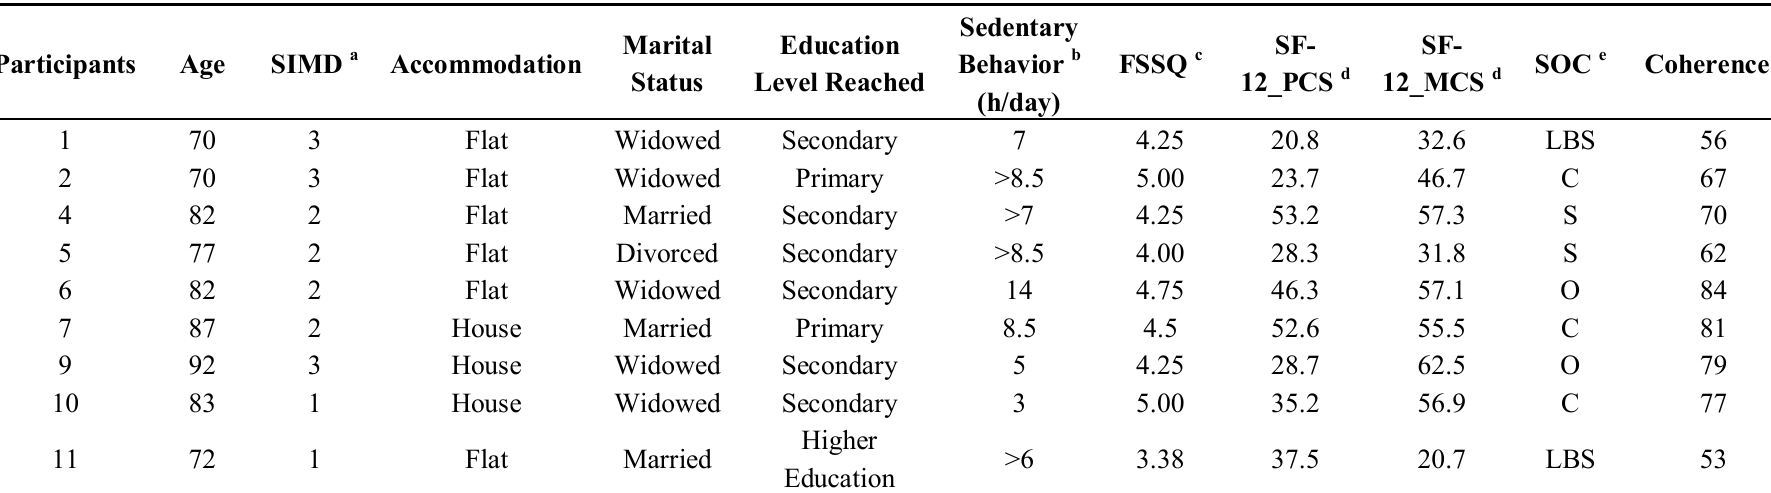
Table 1. Participants demographics and questionnaire scores (SBQ: Sedentary Behavior Questionnaire, FSSQ: Functional Social Support Questionnaire, SF-12_PCS: Physical health, SF-12_MSC: Mental health).